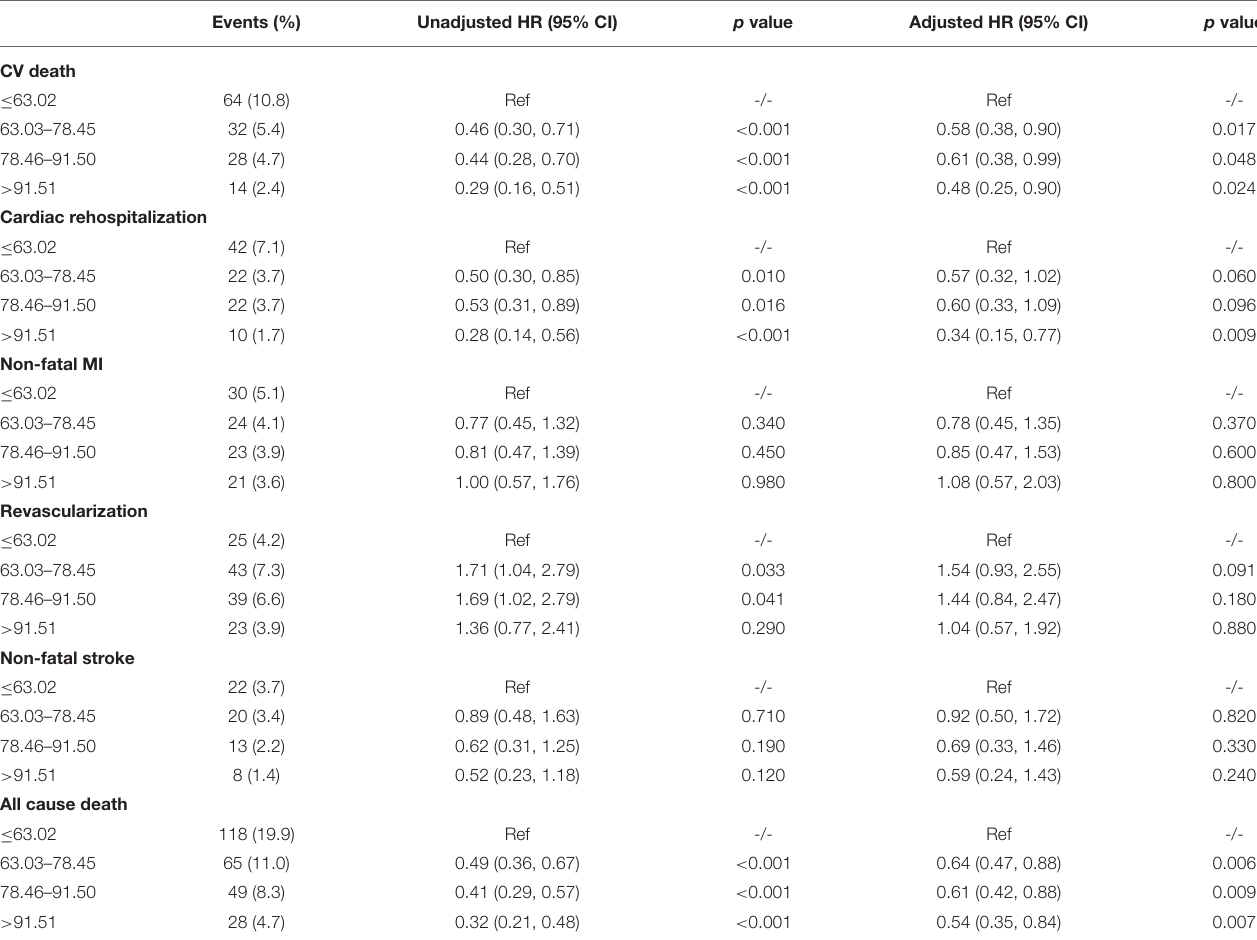
TABLE 2 | Competing risk model of clinical